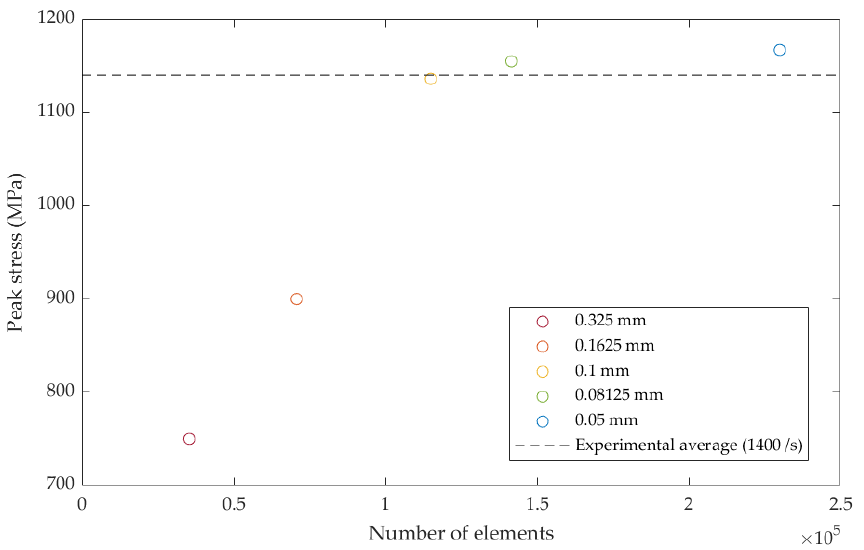
Figure 14. Mesh dependency study indicating that the 0.1 mm is the optimal element size. The strain rates that were achieved in the SHPB experiment were replicated in the model. To achieve this, the fixture was prescribed with the (average) initial velocity ob- served in the experiment and the same inertia (mass) of the SHPB setup (either the alumi- num or steel bar) with respect to the desired strain rate. The input parameters used to describe the model in LS-DYNA ® can be found in Table 5. Table 5. Parameters used to describe the mechanical properties of the T700/PA6.6 CFRTP compo- site [47,53] and the contact surface. Decoupled in-Plane Mechanical Properties Longitudinal Young’s modulus, in the fibre direction, (cid:1831) (cid:3028) (GPa) 129 Transverse Young’s modulus, (cid:1831) (cid:3029) (GPa) 5.0 Shear modulus, (cid:1833) (cid:3028)(cid:3029) (GPa) 3.2 Longitudinal tensile strength, (cid:1850) (cid:3047) (MPa) 2400 Longitudinal compressive strength, (cid:1850) (cid:3030) (MPa) 1500 Transverse tensile strength, (cid:1851) (cid:3047) (MPa) 156 Transverse compressive strength, (cid:1851) (cid:3030) (MPa)